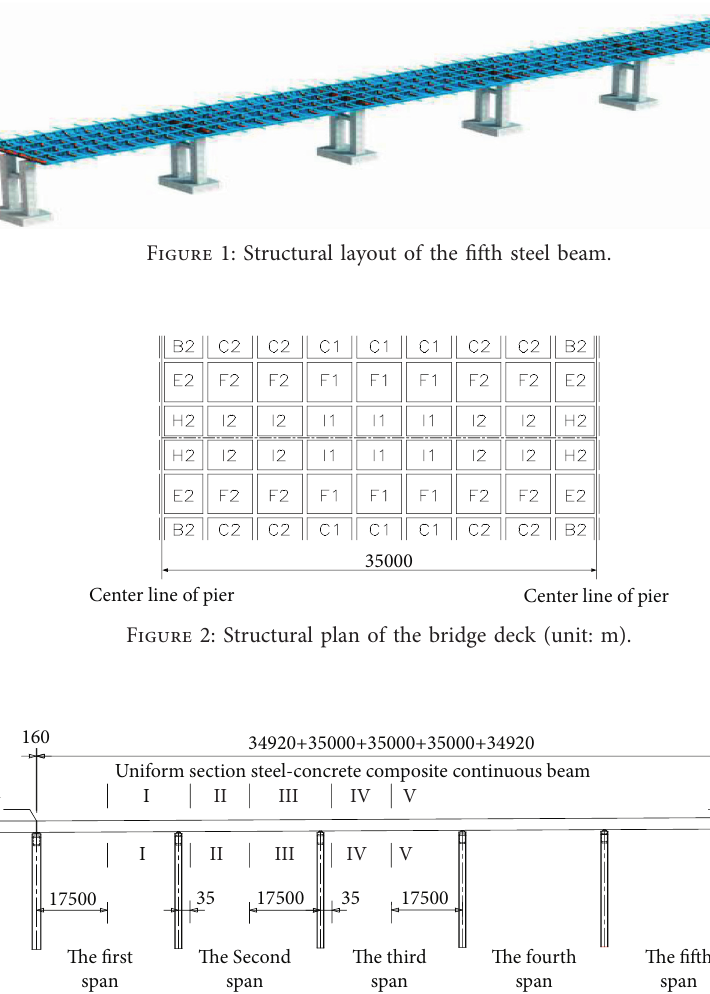
Figure 3: Location of the test section (unit: mm).